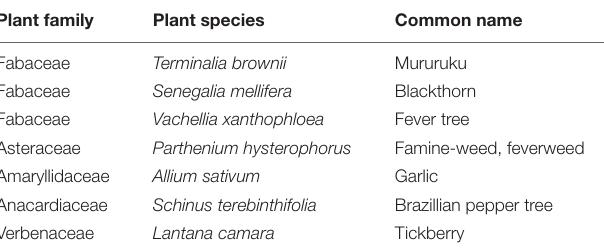
TABLE 2 | List of scientific and common names of plant species that provide sugar source for Stomoxys calcitrans . Plant